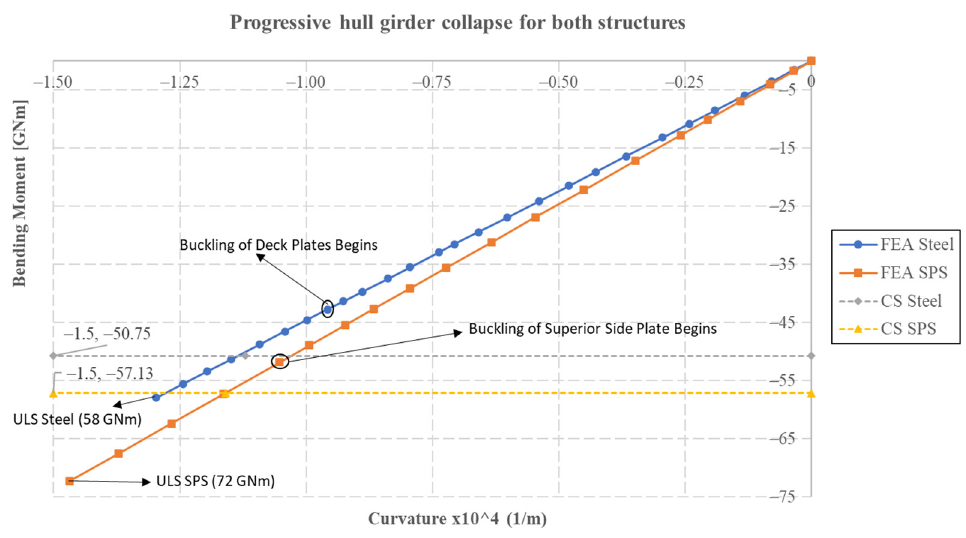
Figure 10. ULS for both designs.